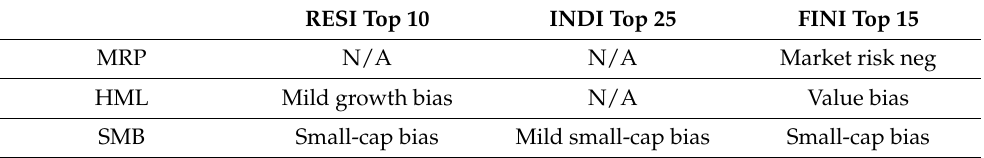
Table 6. Summary of styles present in sectors using FF3FM.